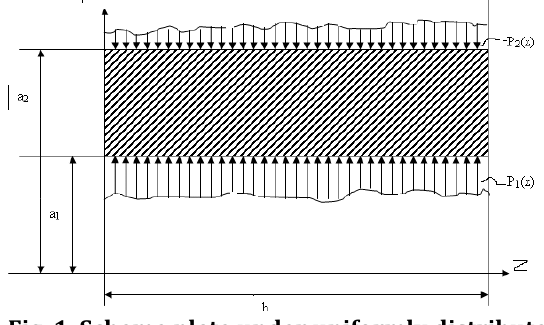
Fig. 1. Scheme plate under uniformly distributed